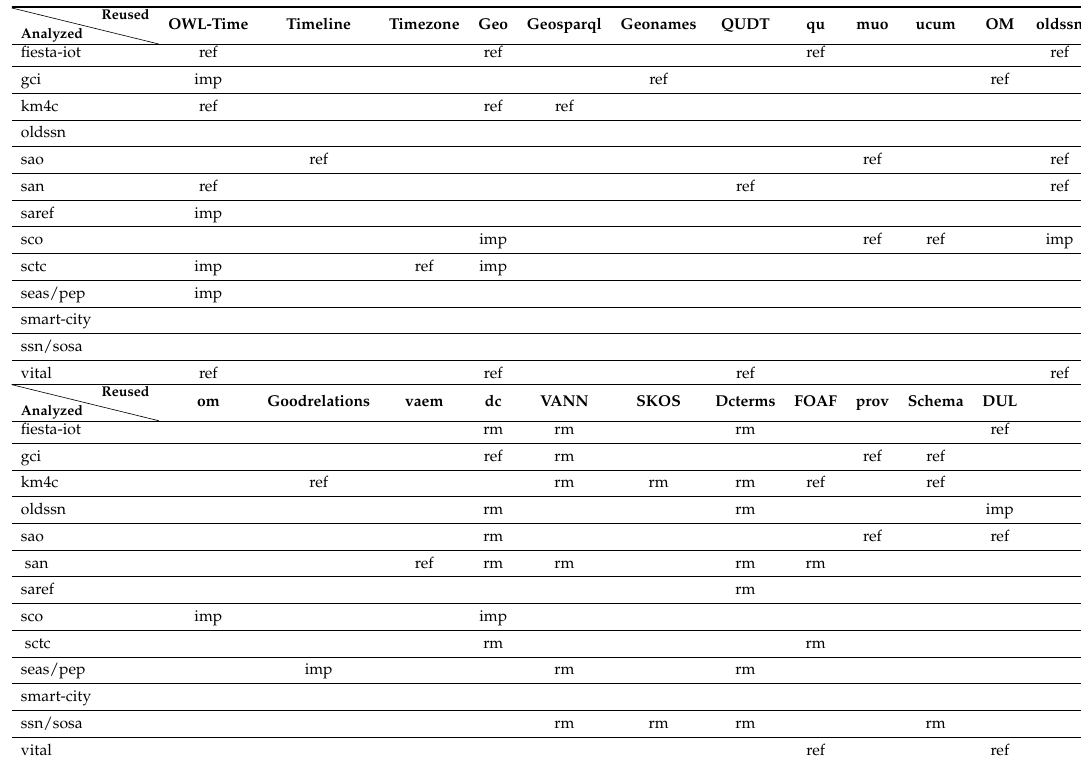
Table 4. Ontologies reused (ref = referenced, imp = imported, rm = referenced as metadata) by smart city